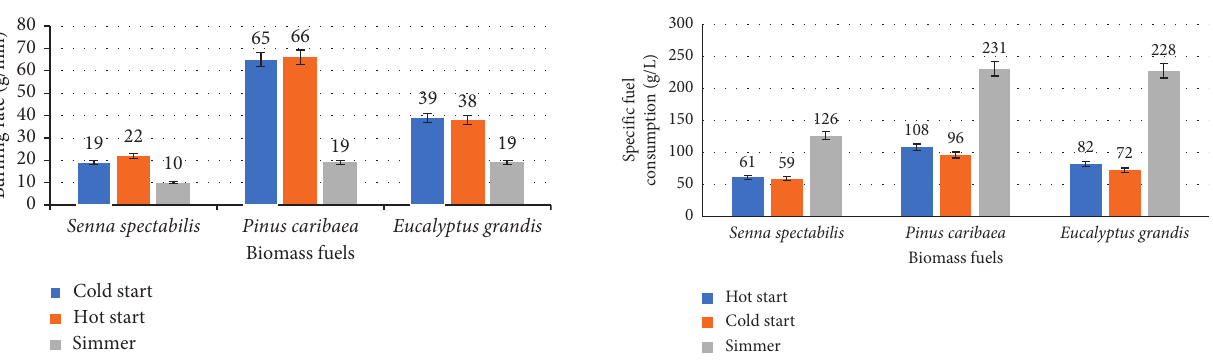
Figure 8: Burning rate of the selected biomass fuels on the fire stove prototype.